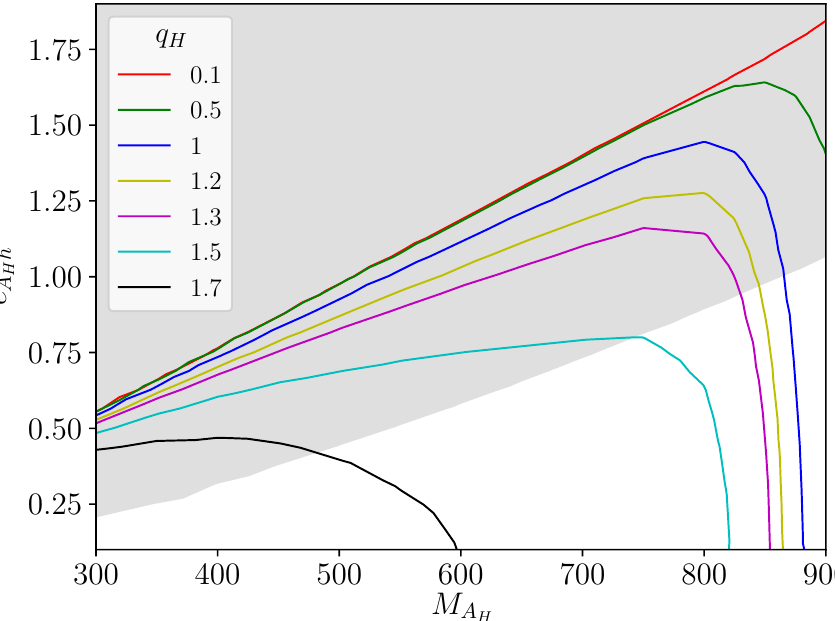
Figure 15 . Contours of Ω h 2 = 0 . 12 for fixed values of q H and M E = 1 TeV . The region below the curves gives too large DM density and is excluded. The shaded region is excluded from direct detection experiments. See text for